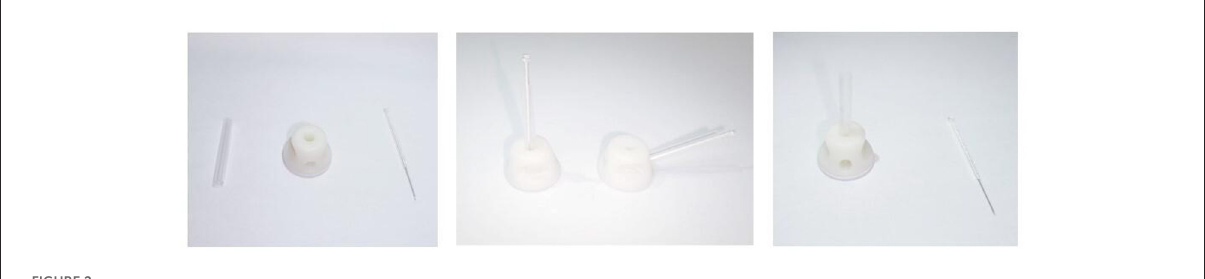
FIGURE2 Schematic diagram of the new acupuncture